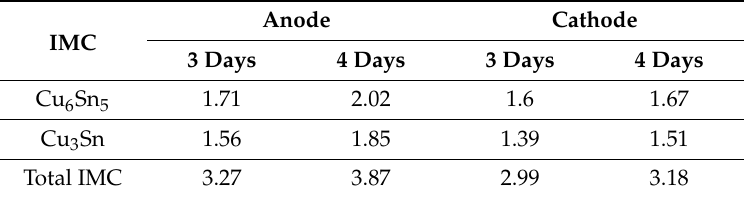
Table 3. The IMC formation and their corresponding thickness in the sample heated at 130 ◦ C and subjected to a current of 0.8 A.